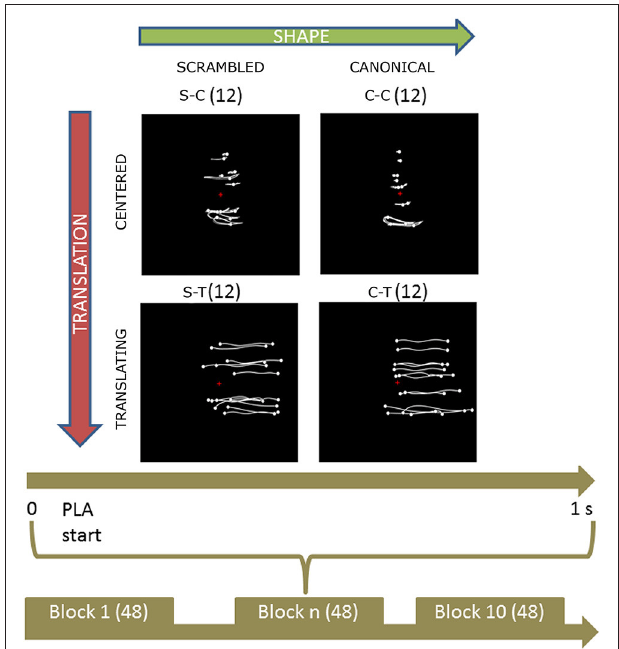
FIGURE 1 | Experimental protocol and stimuli displays. Upper part shows the four categories of stimuli. Body joint trajectories (in white) are depicted on black screen for illustrative purposes but were not visible during the actual experiment. From left to right (upper horizontal green arrow), stimuli shape change from a scrambled structure to a real walker body structure. From top to bottom (left lateral yellow arrow), stimuli keep the same shape but change from a centered to a translated display. Abbreviations: S-C and C-C for scrambled and canonical centered PLW respectively; S-T and C-T for scrambled and canonical translating PLW. The trajectories of the markers during the whole point light animation (PLA) are shown. The lower part sums up the experimental protocol. During each of the 10 experimental blocks of 48 trials, every condition was randomly presented 12 times for 1s. During each trial, subjects were told to anchor their gaze on the red cross displayed in the middle of the